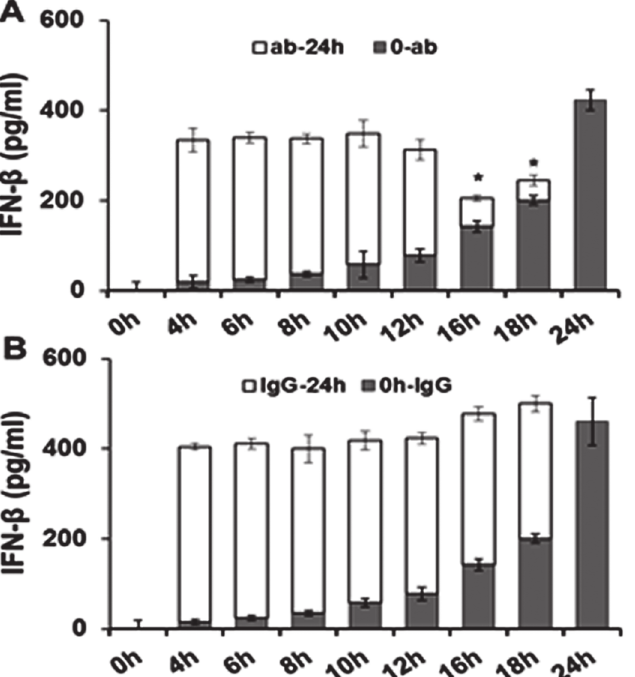
Fig 4. Disruption of IFN- β autocrine-paracrine pathways with neutralizing antibody. Bm1.11 cells were infected with 10 IFU/ cell C . muridarum to measure the amount of IFN- β secreted into the supernatants for 24 hours by ELISA. The supernatants were supplemented at each time-point listed with either 0.1 μ g/ml of: (A) IFN- β neutralizing antibody, or (B) isotype control antibody. The amount of IFN- β secreted into the supernatants after the addition of antibody (ab/IgG-24h) was estimated by subtracting out the amount of IFN- β secreted in control experiments in which supernatants were instead collected and assayed for IFN- β synthesis at the same time-point (see Materials and Methods). Results are representative data from one of three independent experiments . * = p < 0.05 compared to 24h C . muridarum infection control ; 0-ab/IgG denotes “ 0hr PI until time antibody added ” ; ab/IgG-24h denotes “ time antibody added until 24h PI ”